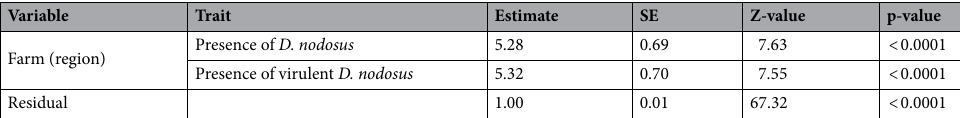
Table 3. Variance parameter estimates with their standard errors (SE), Z-values and p-values for the variables infection with D. nodosus ( aprV2 + /aprB2 +) and infection with virulent D. nodosus in the generalized linear mixed